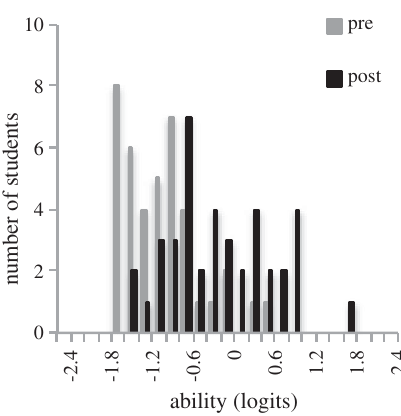
FIG. 28. The pre- and postability histograms for class 14.